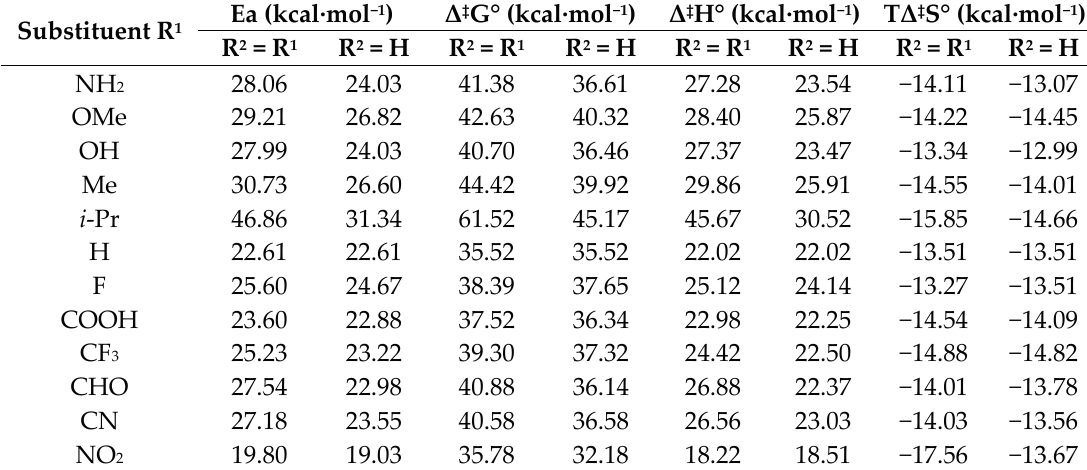
Table 5. Activation energy Ea, standard activation Gibbs energy Δ ‡ G°, standard activation enthalpy Δ ‡ H°, and standard activation entropy T Δ ‡ S° for the Diels-Alder reactions of butadiene with the substituted fragment 2 . Data for the reaction with the non-substituted fragment (H) are given as